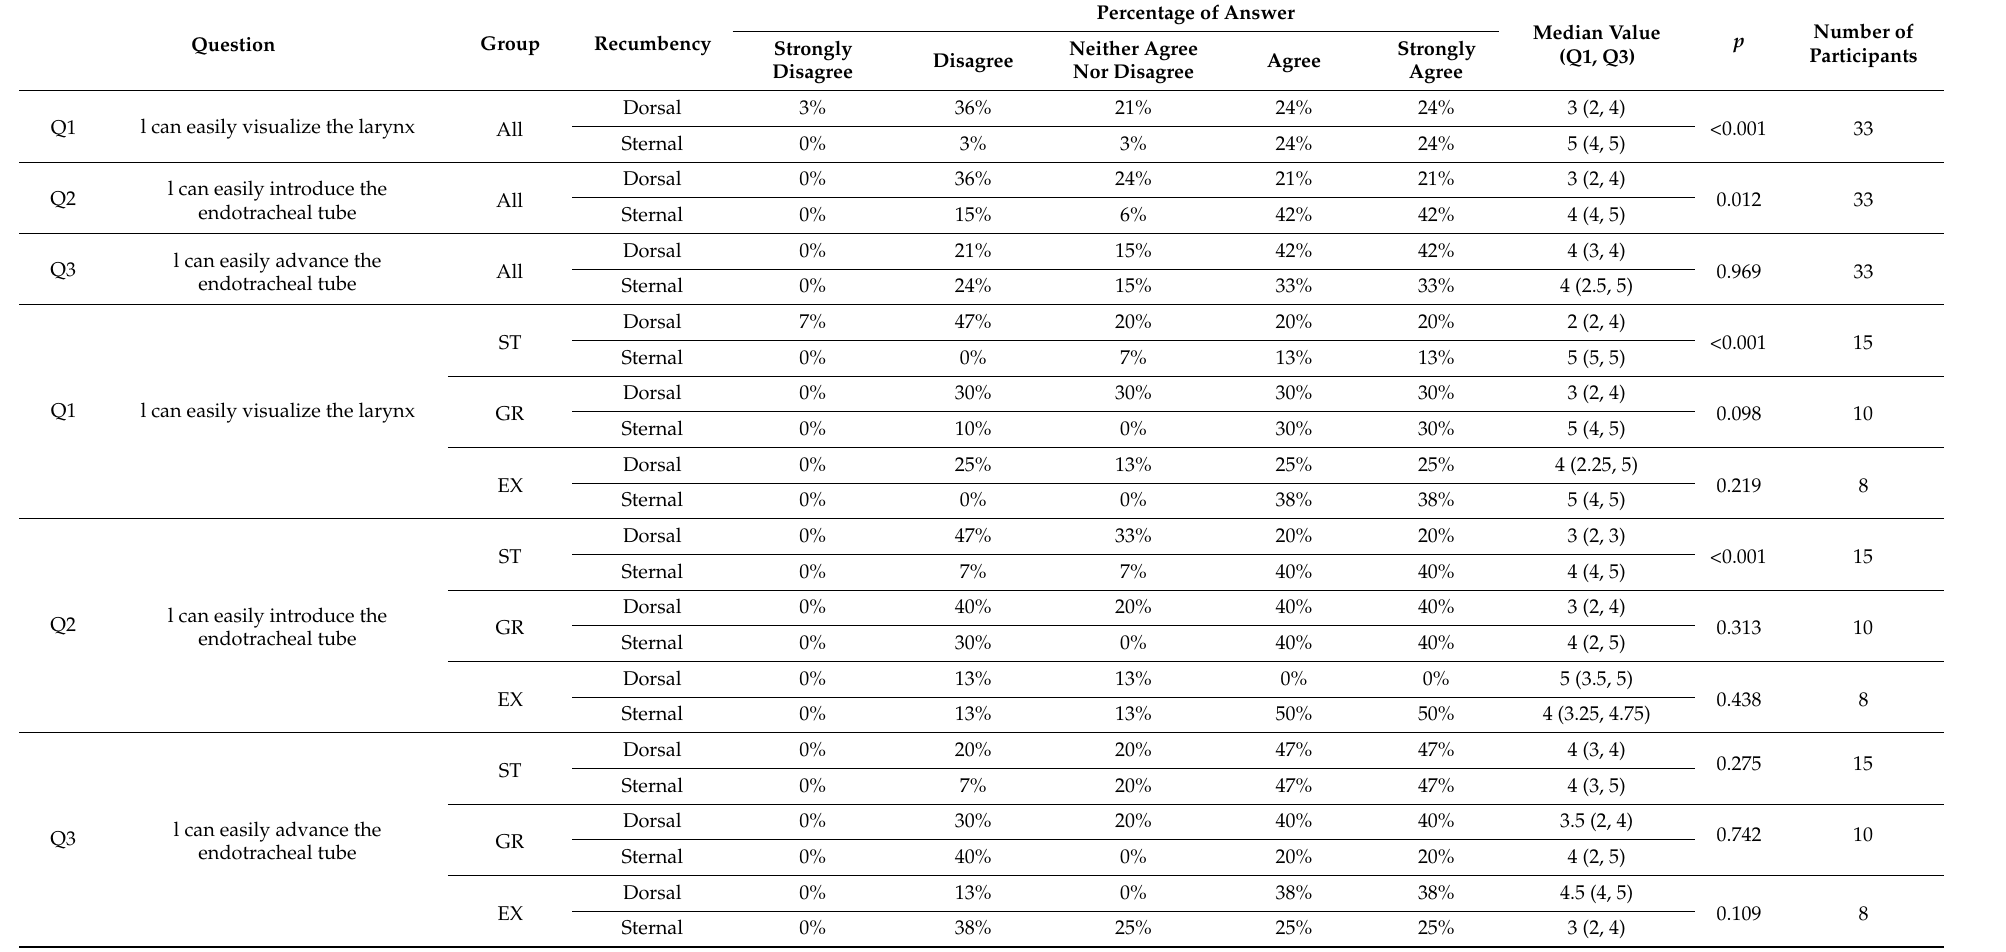
Table 1. Answers to the three Likert questions. The subgroup analysis and the number of participants for each group are also